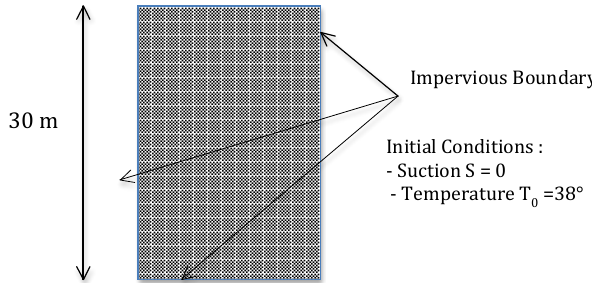
Figure 1. Scheamtic view of Wilson’s coloumn (Wilson 1990) Fig. 1. Scheamtic view of Wilsons colomn (Wilson, 1990).